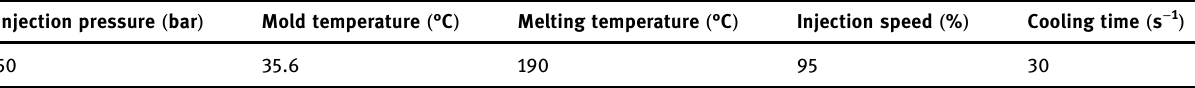
Table 1: Foamed polypropylene composites injection molding technique parameters Injection pressure ( bar )